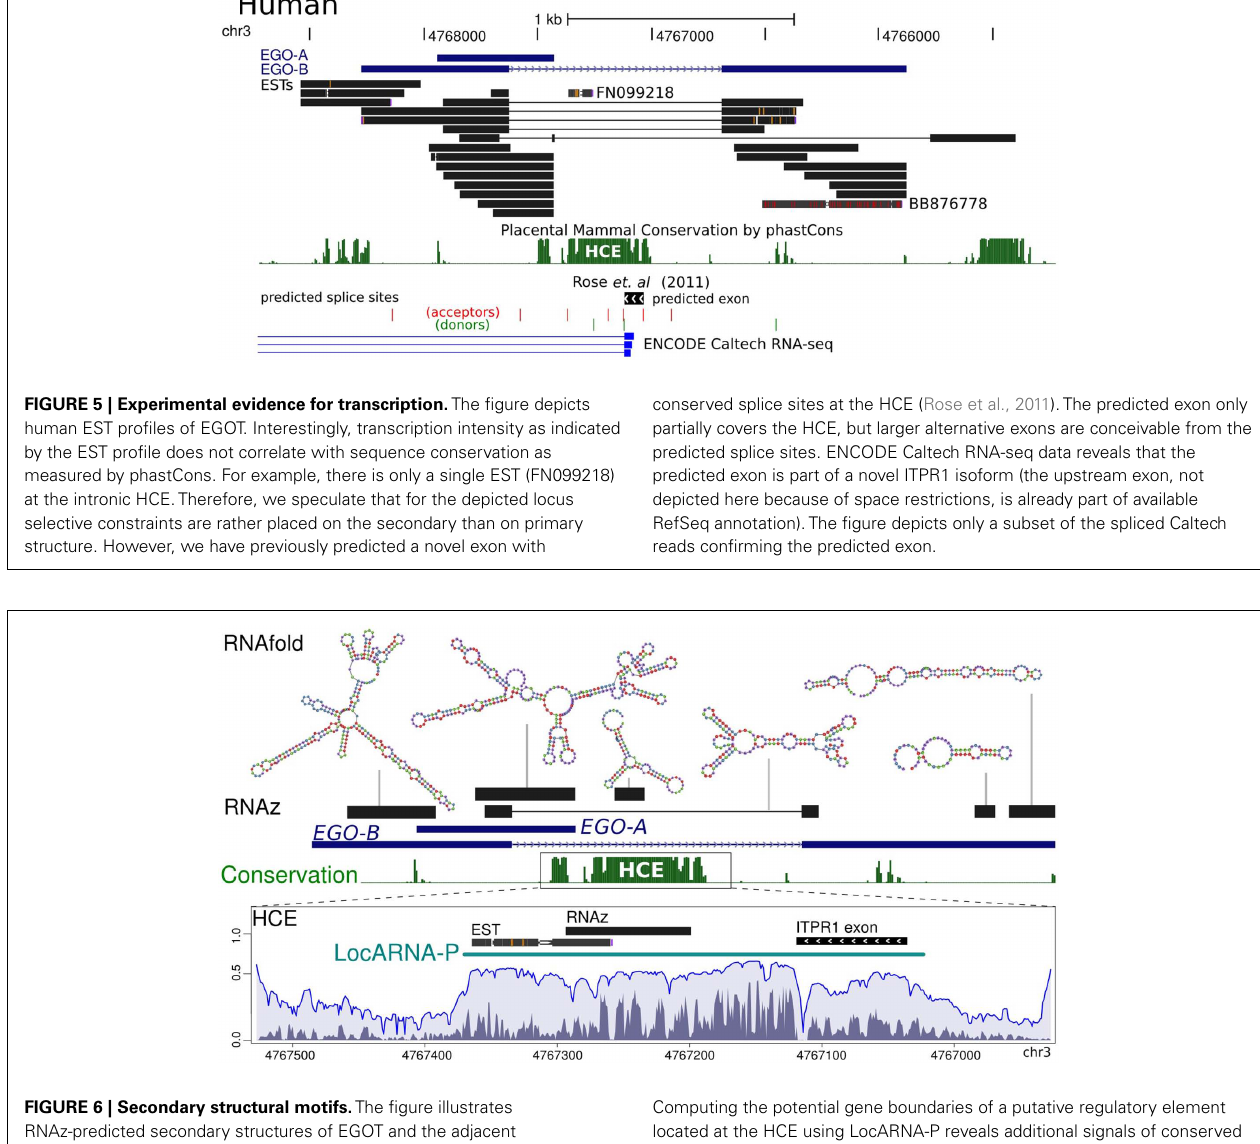
FIGURE 6 | Secondary structural motifs. The figure illustrates RNAz-predicted secondary structures of EGOT and the adjacent intronic HCE. Both loci exhibit signals of thermodynamically stable and evolutionary conserved secondary structures.We provide the approximate genomic position and the predicted minimum free energy structure (RNAfold) for each RNAz hit.